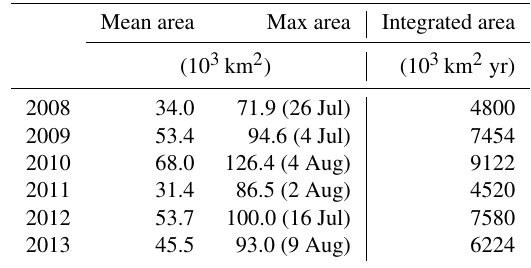
Table 1. Extent of P limitation on the shelf in 2008–2012 and timing of the maximum